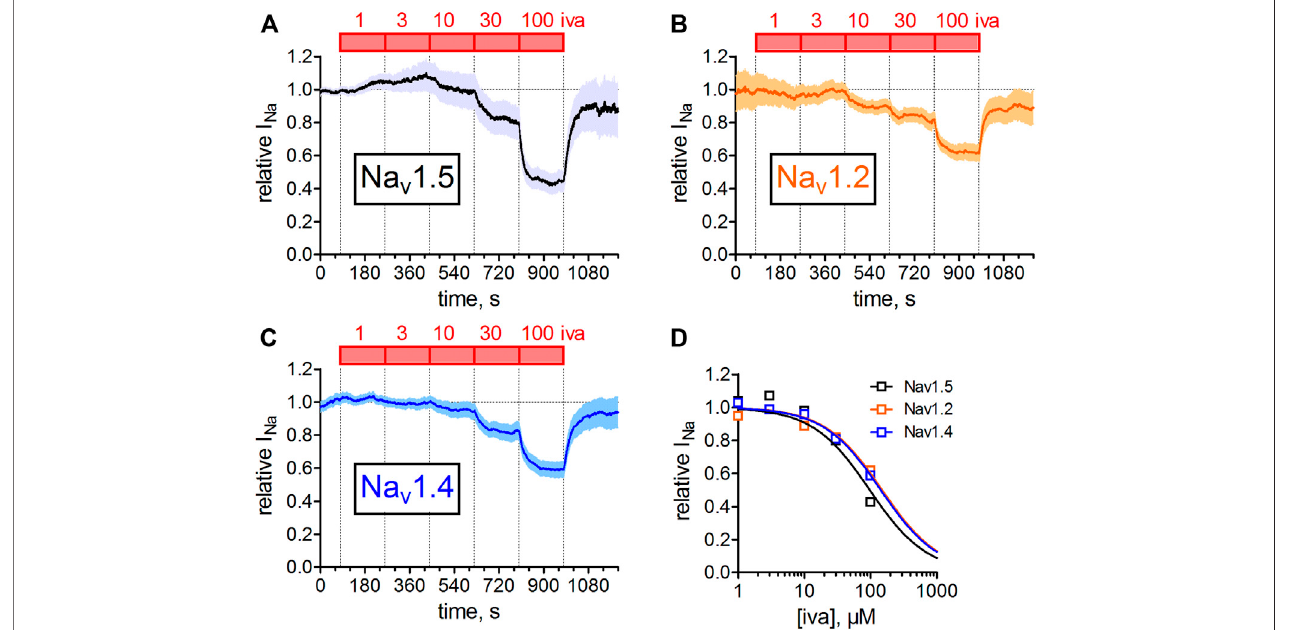
FIGURE 7 | Concentration-dependent inhibition of different VGSC isoforms. Automated patch-clamp recordings of sodium currents through Na v 1.2, Na v 1.4, and Na v 1.5 channels. Sodium currents were elicited from a holding potential of − 150 mV by 25 ms depolarizing voltage steps to − 10 mV. Ivabradine was applied at increasing concentrations (1, 3, 10, 30, 100 µM) for 3 min each. Mean data from 12, 15, and 12 channels are shown for Na v 1.2, Na v 1.4, and Na v 1.5, respectively. Data were fi t to a Hill equation with a Hill coef fi cient of n H = 1 to estimate half points of inhibition. IC 50 values (mean ± SEM) amounted to 296 ± 11, 257 ± 15, and 137 ± 8 µM for Na v 1.2, Na v 1.4, and Na v 1.5. One-way ANOVA with Tukey ’ s post-hoc test revealed a statistical difference between Na v 1.5 and Na v 1.2 ( p < 0.001) and Na v 1.4 ( p < 0.001), but not between Na v 1.2 and Na v